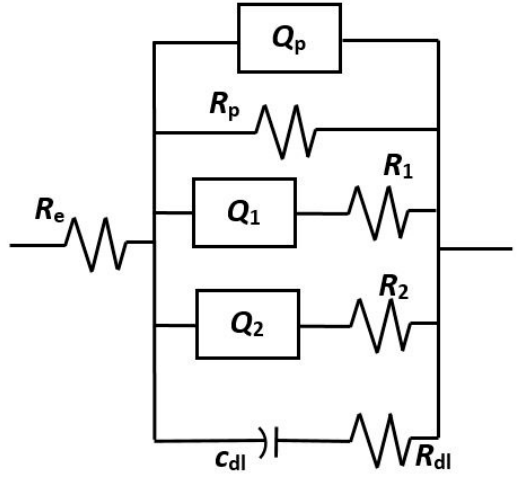
Figure 3. Selected model of EIS equivalent electrical